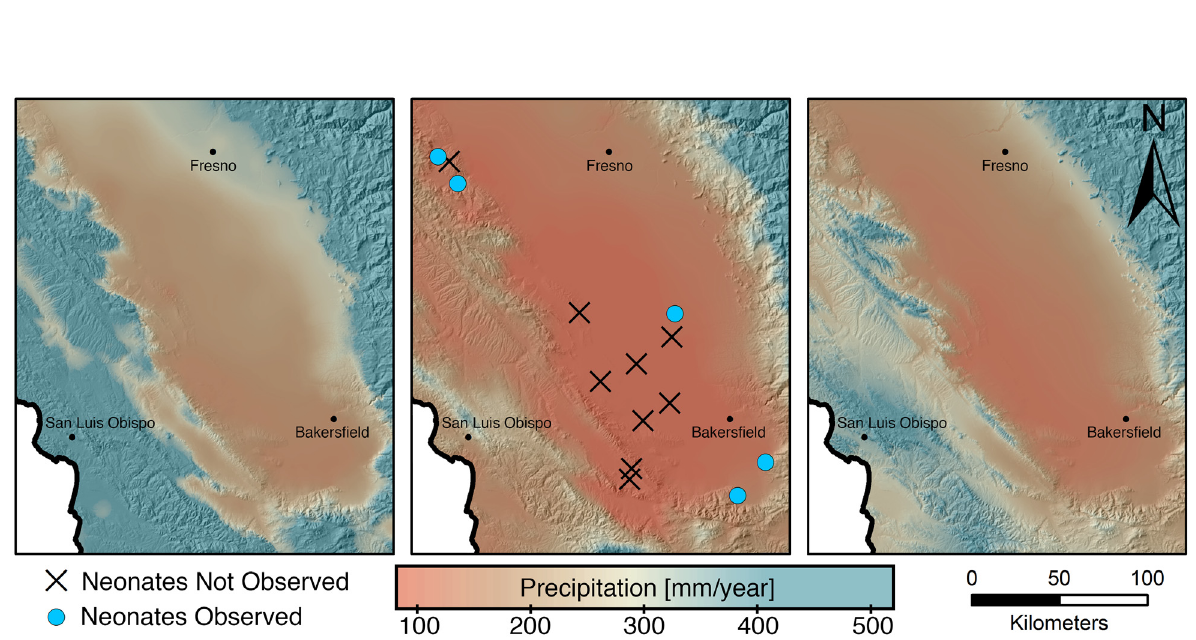
Fig 2. Comparison of past, present and predicted drought patterns and G . sila recruitment. Map backgrounds are colored by mean annual precipitation for recent (1981 – 2010, left panel), 2014 water year (middle panel), and projected future (2070 – 2099, MIROC-ESM RCP8.5, right panel) periods. Results of 2014 surveys for G . sila neonates are shown in the middle